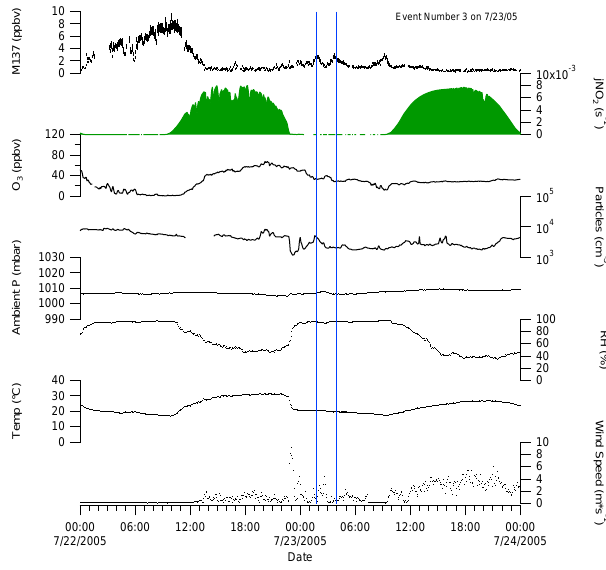
Fig. 4. An example Type B event, in which the mixing ratios of monoterpenes peak for a brief period of time, from 11 May 2007.